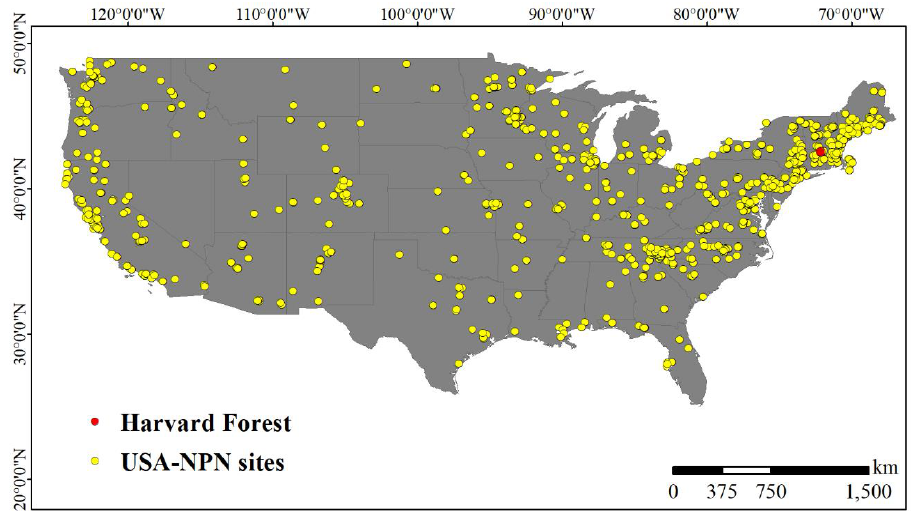
Figure 2. The USA-NPN sites and the Harvard Forest site used in this study.